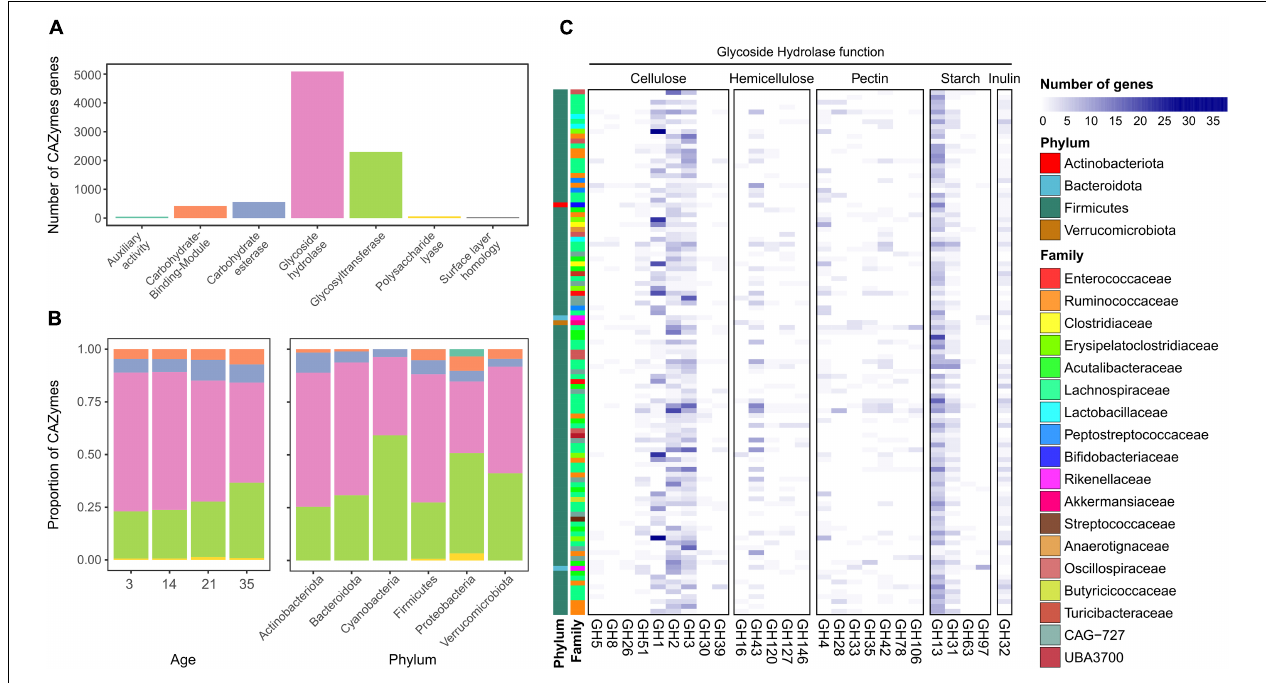
FIGURE 3 | (A) Number of Carbohydrate Active Enzymes (CAZymes) genes identified in the metagenomic assembled genomes (MAGs) from the chicken gut. (B) Proportion of CAZymes at different ages and in the different taxonomic families. (C) Abundance and distribution of the most commonly found CAZyme genes from the glycoside hydrolase family according to MAG family and